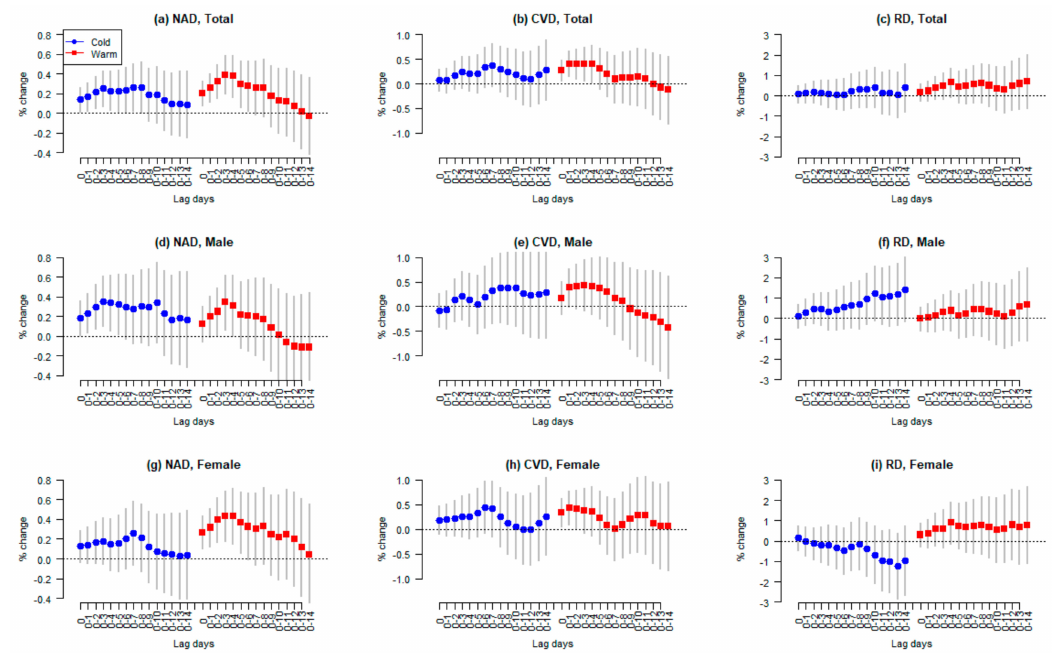
Figure 5. Lag structures of the e ff ects of a 10 µ g / m 3 increase in PM 10 on mortality in elderly Seoul residents, by disease category, sex, and season. Seasons were classified into warm months (April to September) and cold months (October to March). ( a ) non-accidental mortality, total; ( b ) cardiovascular disease mortality, total; ( c ) respiratory disease mortality, total; ( d ) non-accidental mortality, male; ( e ) cardiovascular disease mortality, male; ( f ) respiratory disease mortality, male; ( g ) non-accidental mortality, female; ( h ) cardiovascular disease mortality, female; ( i ) respiratory disease mortality,